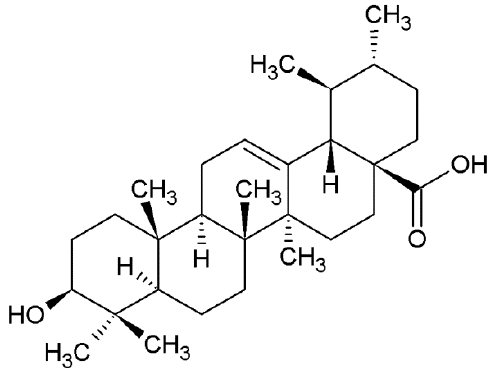
Figure 1. The structure of UA (3 β -hydroxyurs-12-en-28-oic acid).